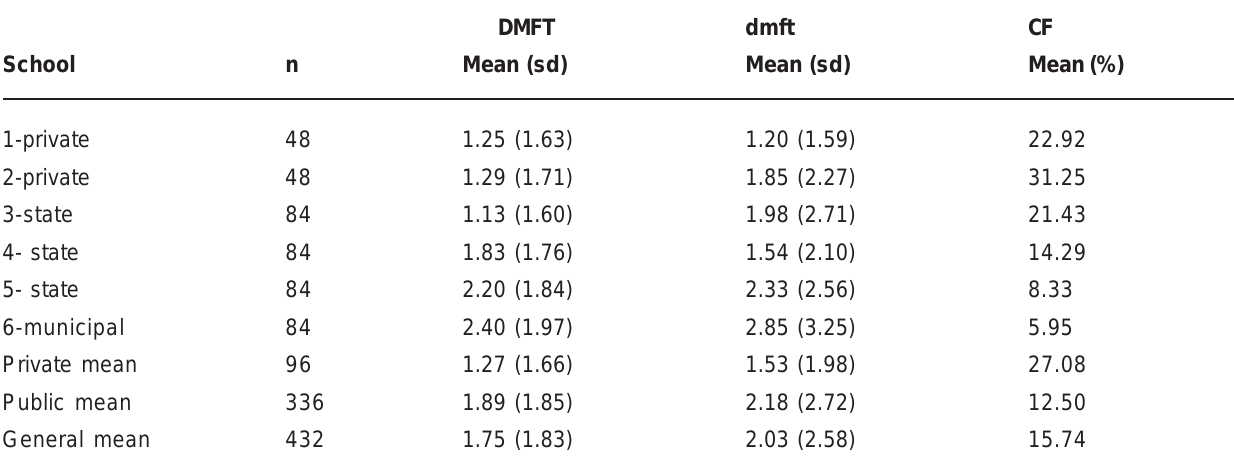
TABLE 2- Mean DMFT, mean dmft (standard deviations) and percentage of 7-12-year-old caries-free (CF) schoolchildren by school in Catalão, DMFT dmft